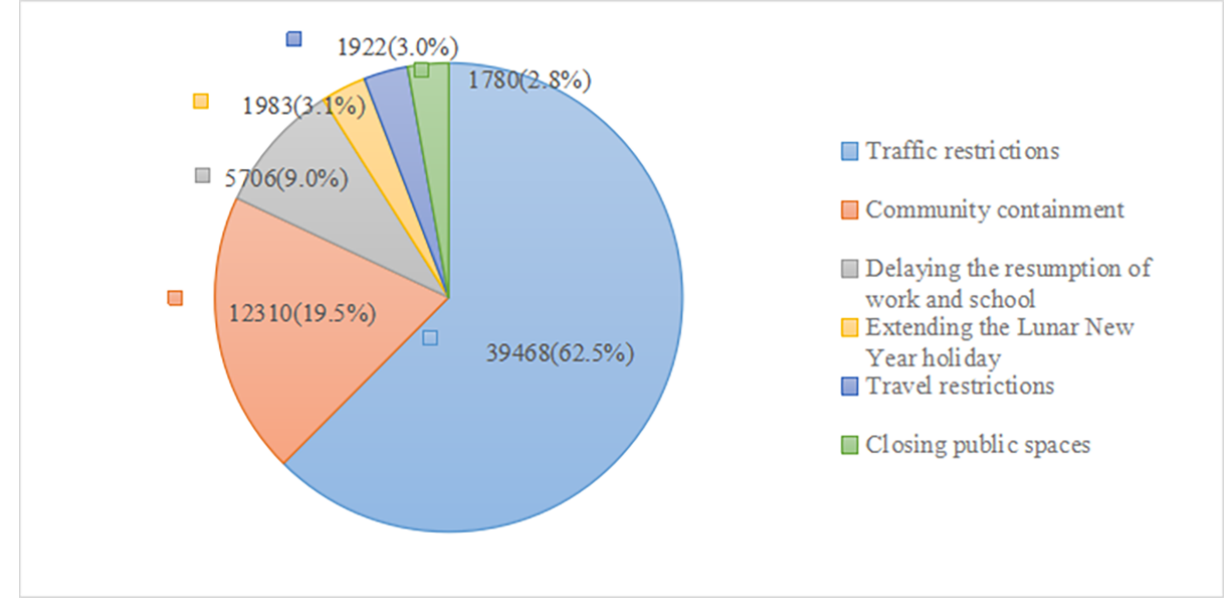
Figure 2. Proportion of comments related to each social distancing measure (N=63,169).